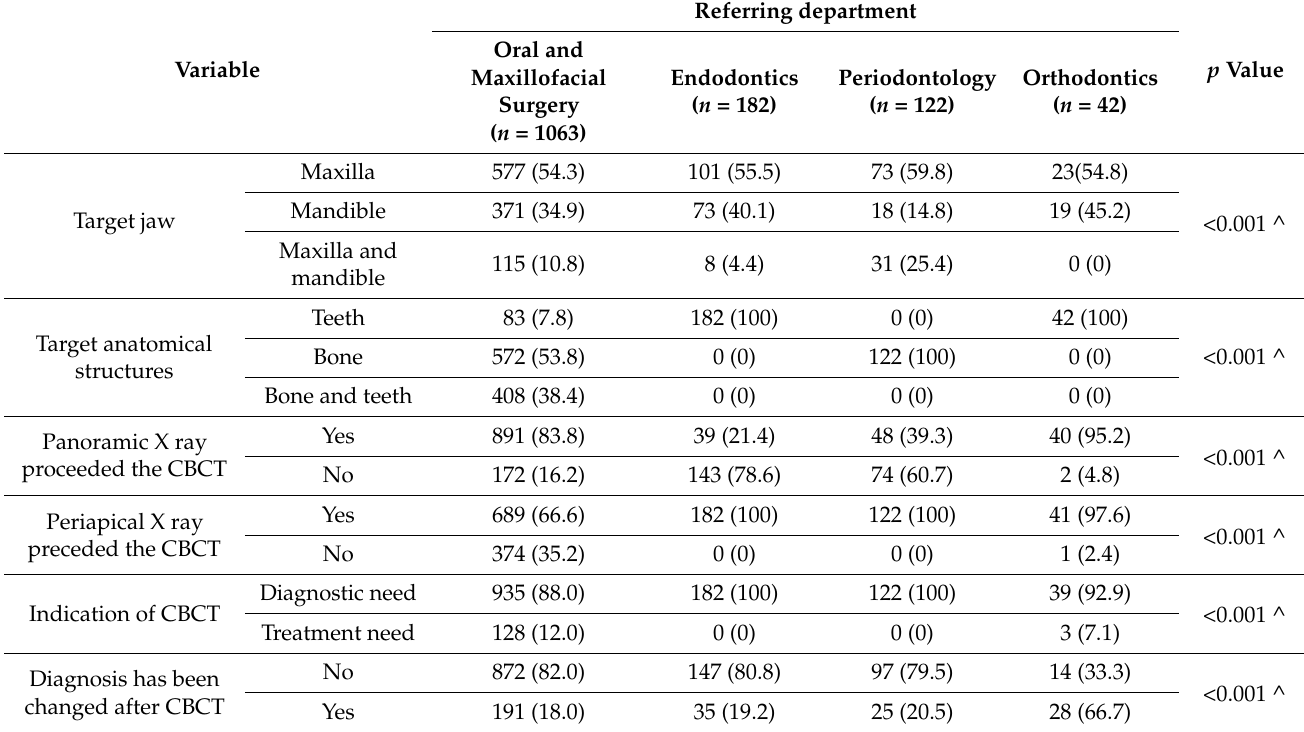
Table 1. Clinical Data Regarding the Patterns of CBCT Usage According to Referring Department